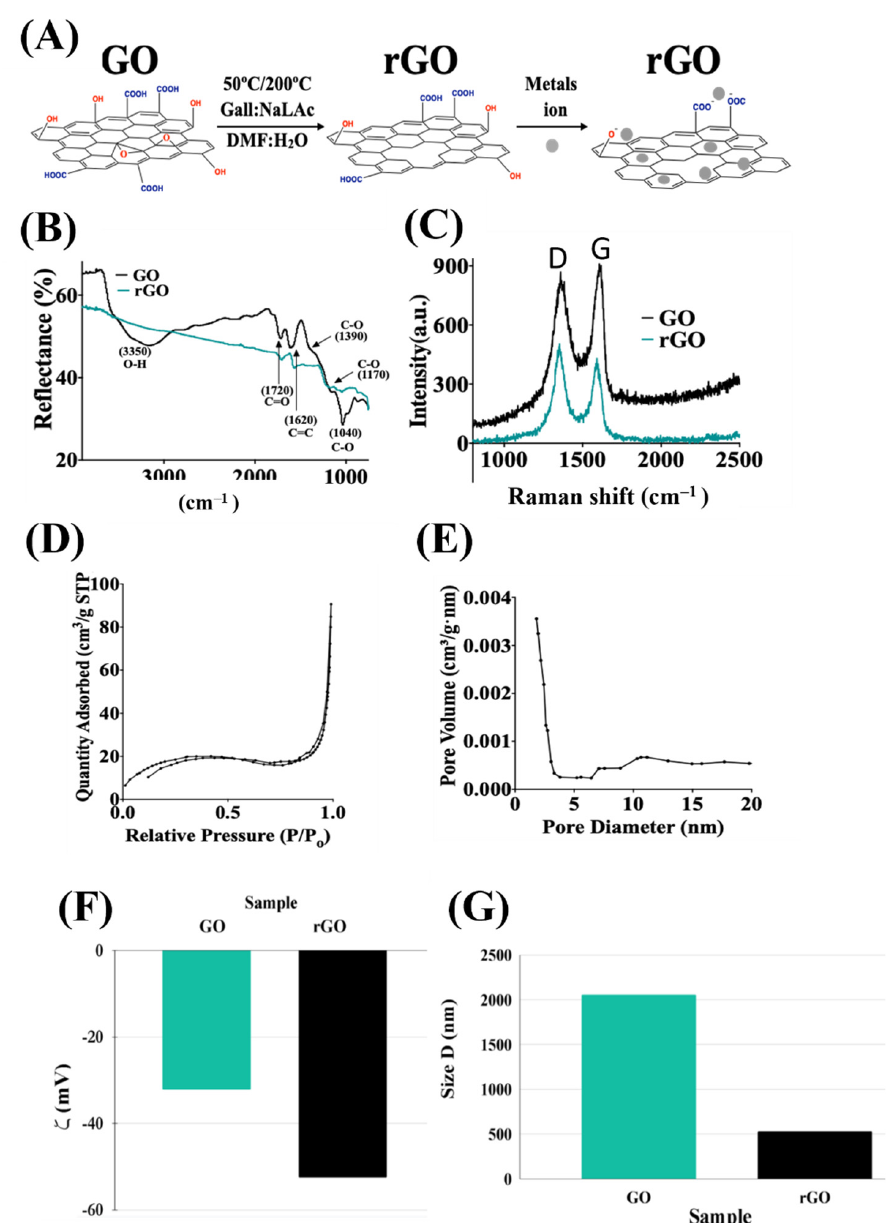
Figure 1. Characterization of rGO. ( A ) Reduction of GO into rGO and its interaction with metal ions. ( B ) FTIR spectra of GO and rGO, showing the conversion of GO to rGO as the peaks associated with oxygen functional groups in GO are removed in rGO spectra. ( C ) Raman analysis of GO and rGO, showing the increase in I D /I G ratio (D:1365 cm − 1 , G: 1595 cm − 1 ), as expected for graphene reduction. ( D ) N 2 adsorption and desorption isotherms. ( E ) Pore size distribution for rGO extracted from nitrogen isotherms. ( F ) Zeta potential values for GO and rGO, indicating a larger number of negative surface charges after reduction to rGO, resulting in strong attraction for positive metal ions. ( G ) Estimation of GO and rGO flake size from zeta-potential.